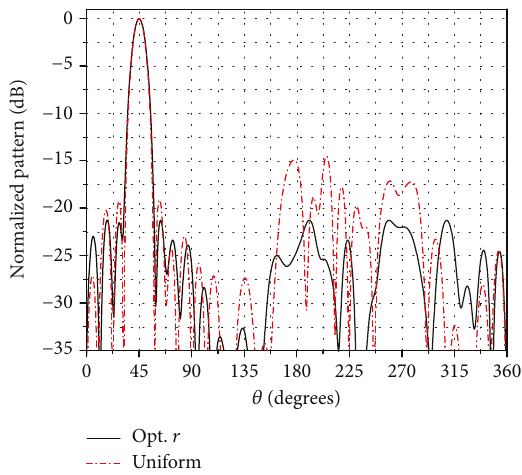
Figure 6: Comparison of normalized power patterns generated by the proposed C-BFN con fi guration with a uniform and nonuniform concentric ring array, optimizing d